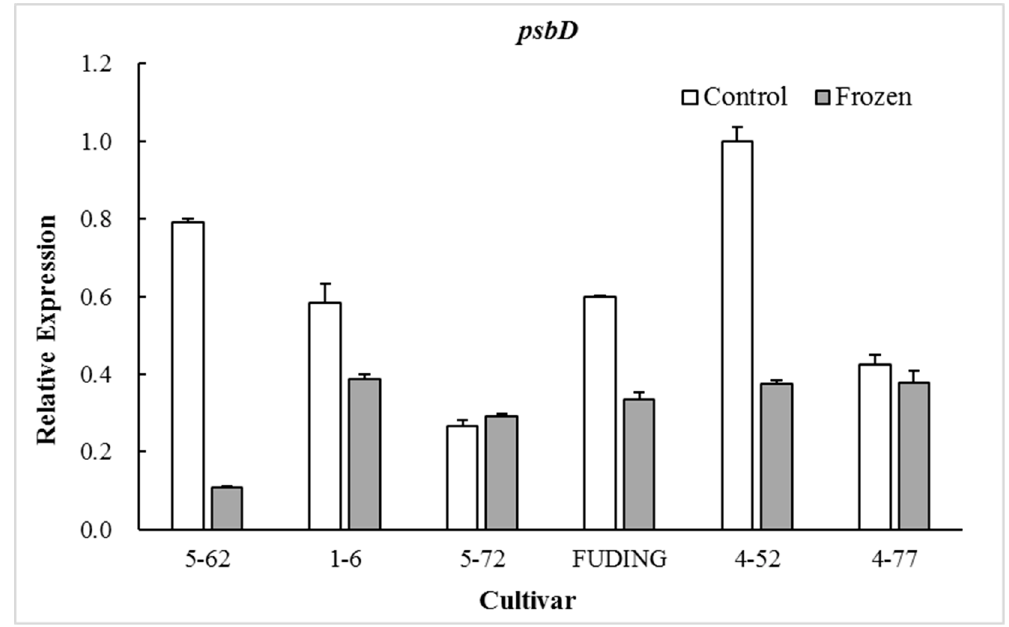
Figure 2. Effect of freezing on the expression of gene psbD . Figure 2. E ff ect of freezing on the expression of gene psbD